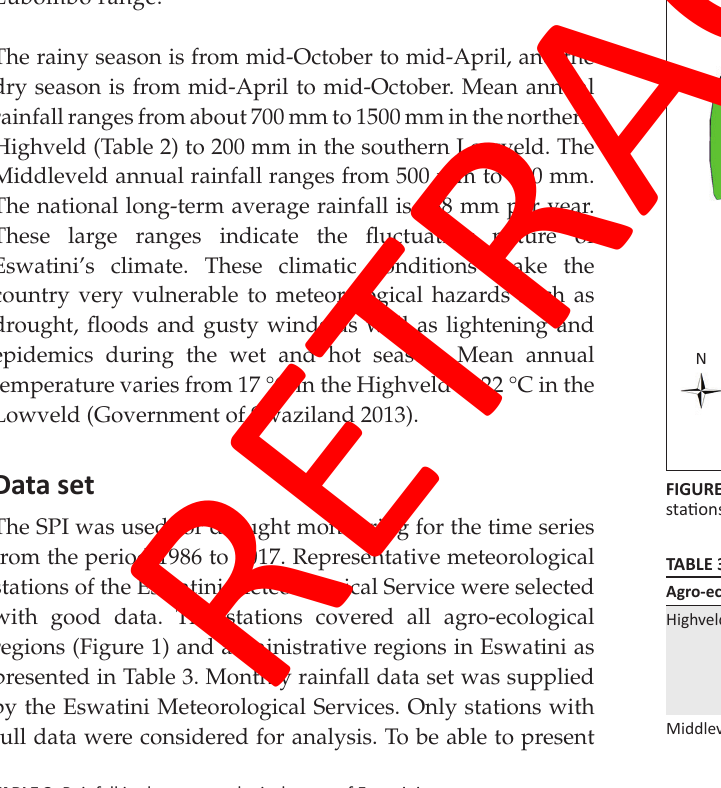
TABLE 2: Rainfall in the agro-ecological zones of Eswatini. Agro-ecological zone